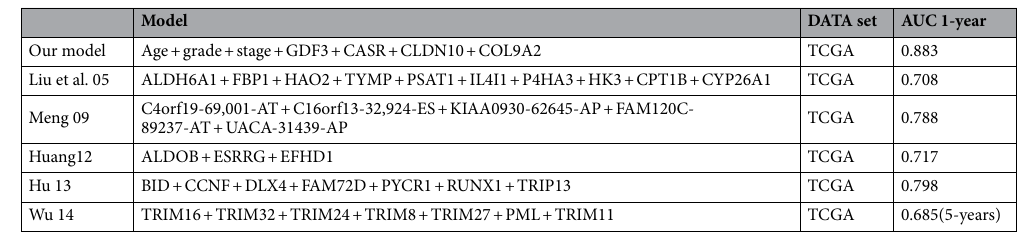
Table 1. Comparison of